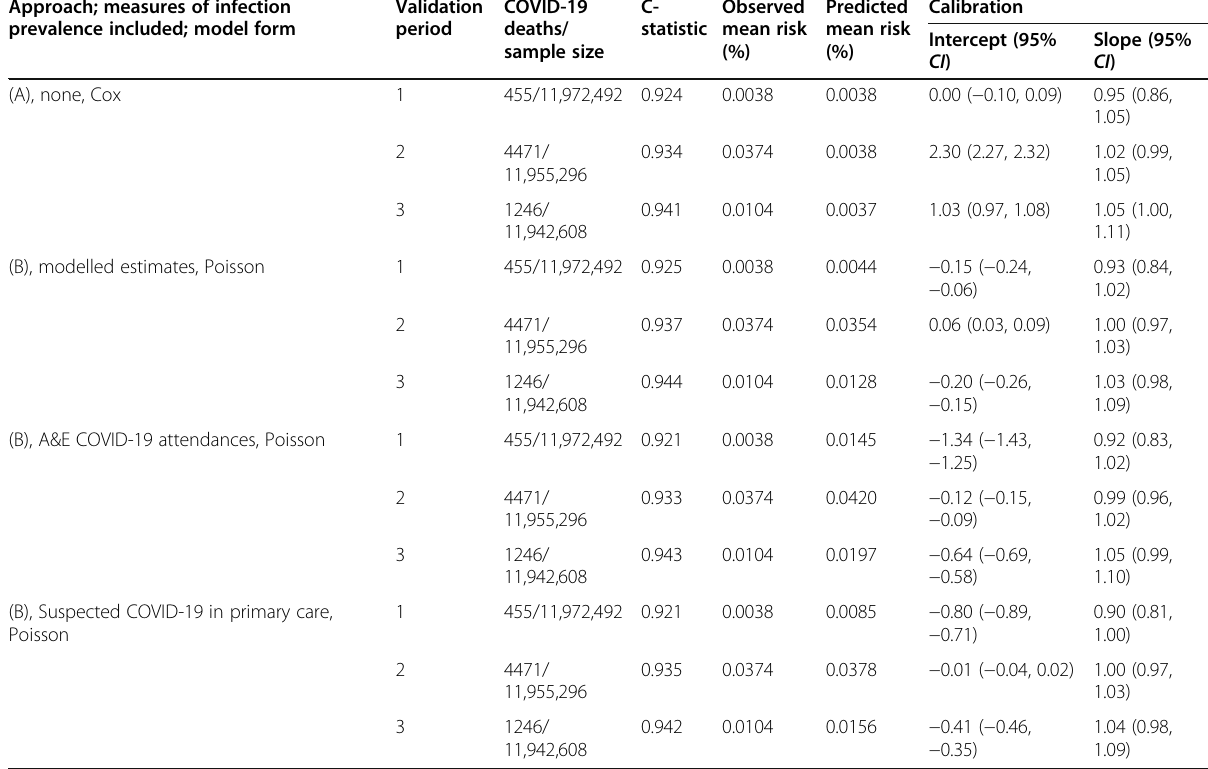
Table 2 Measures of model performance in predicting 28-day risk of COVID-19 mortality, using the “ selected ” models Approach; measures of infection prevalence included; model